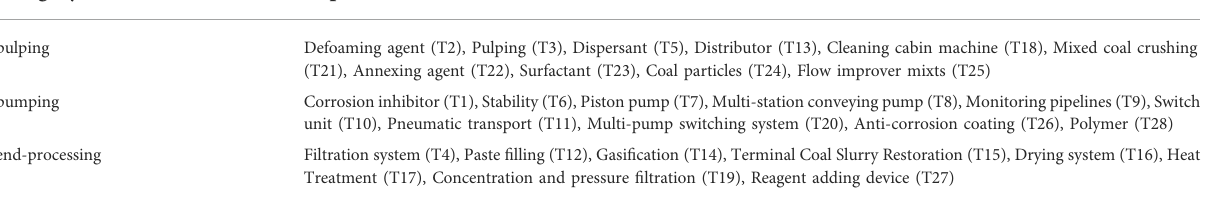
TABLE 3 The classi fi cation results of topics. Category Topic and number